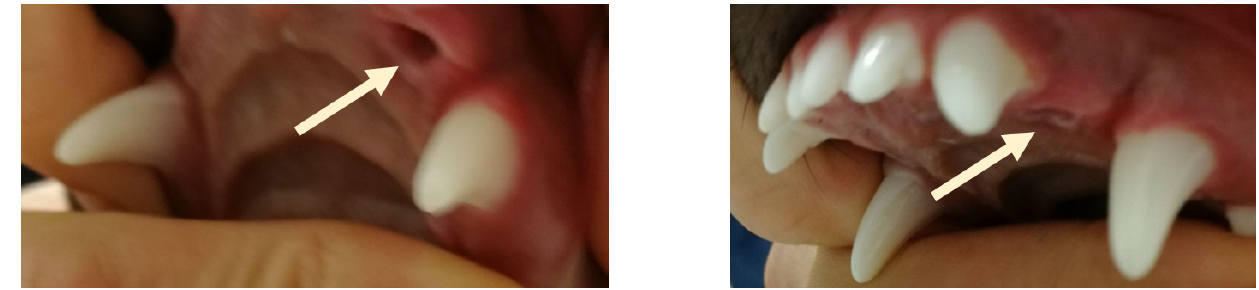
Figure 6. Second case. Intraoral photographs of the maxilla—a visible recess in the palate mucosa caused by the mandibular canine (arrow).